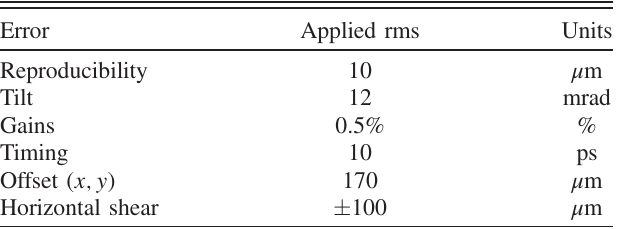
TABLE VII. BPM errors introduced into model CesrTA lattice for RING _ MA 2 studies.